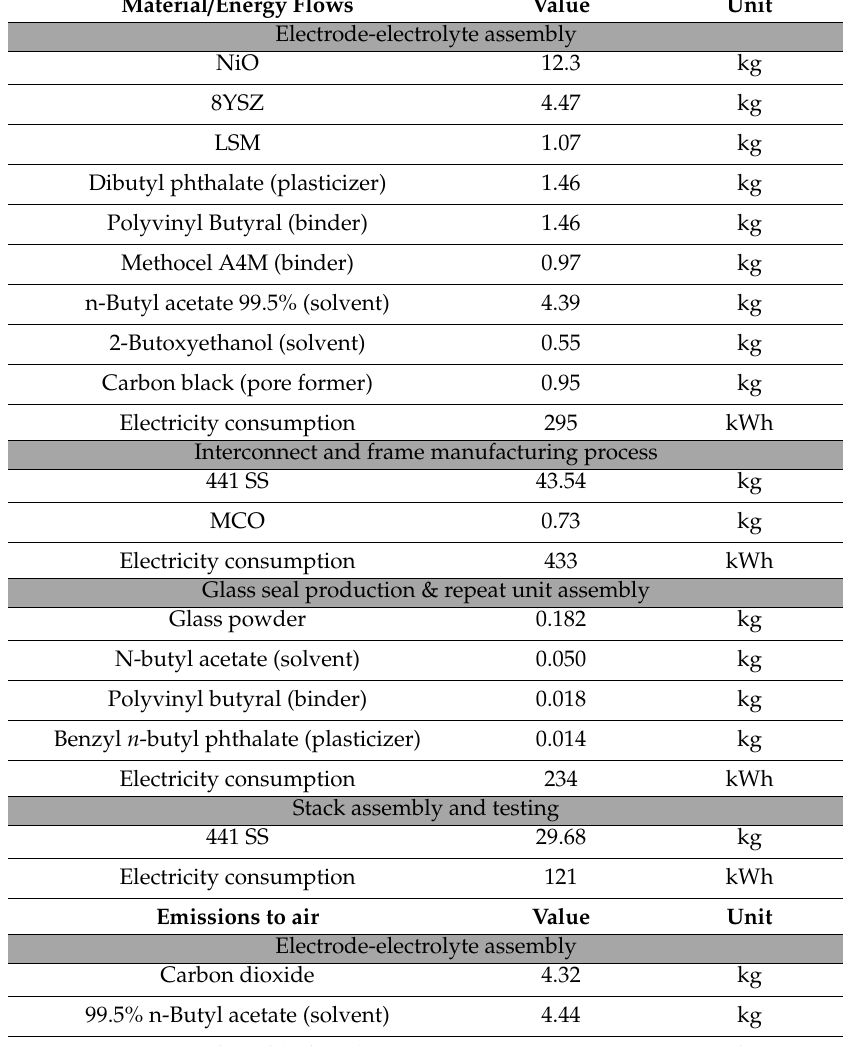
Table 4. Stack manufacture. Reference flow: 1 SOFC stack, net power 10 kW el (data from [40,57]). Material / Energy